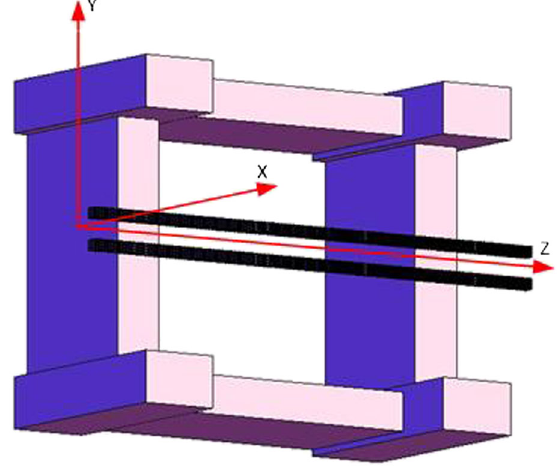
FIG. 6. The simulation model of the APS27 #5s with a frame.